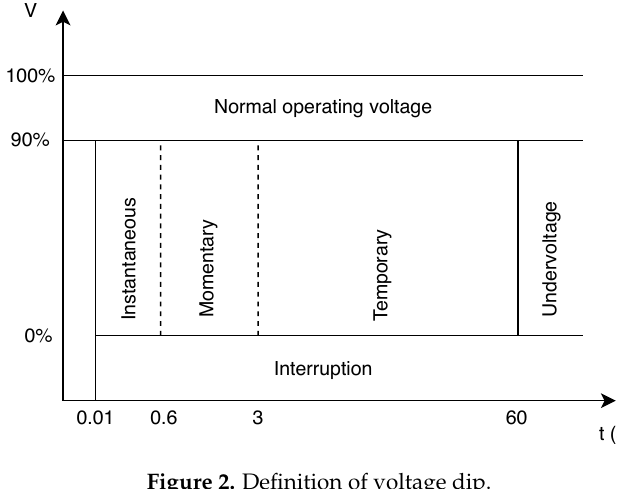
Figure 2. Definition of voltage